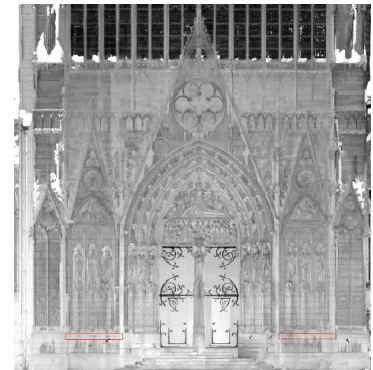
Figure 1. Orthoimage South Transepts Portal, Notre